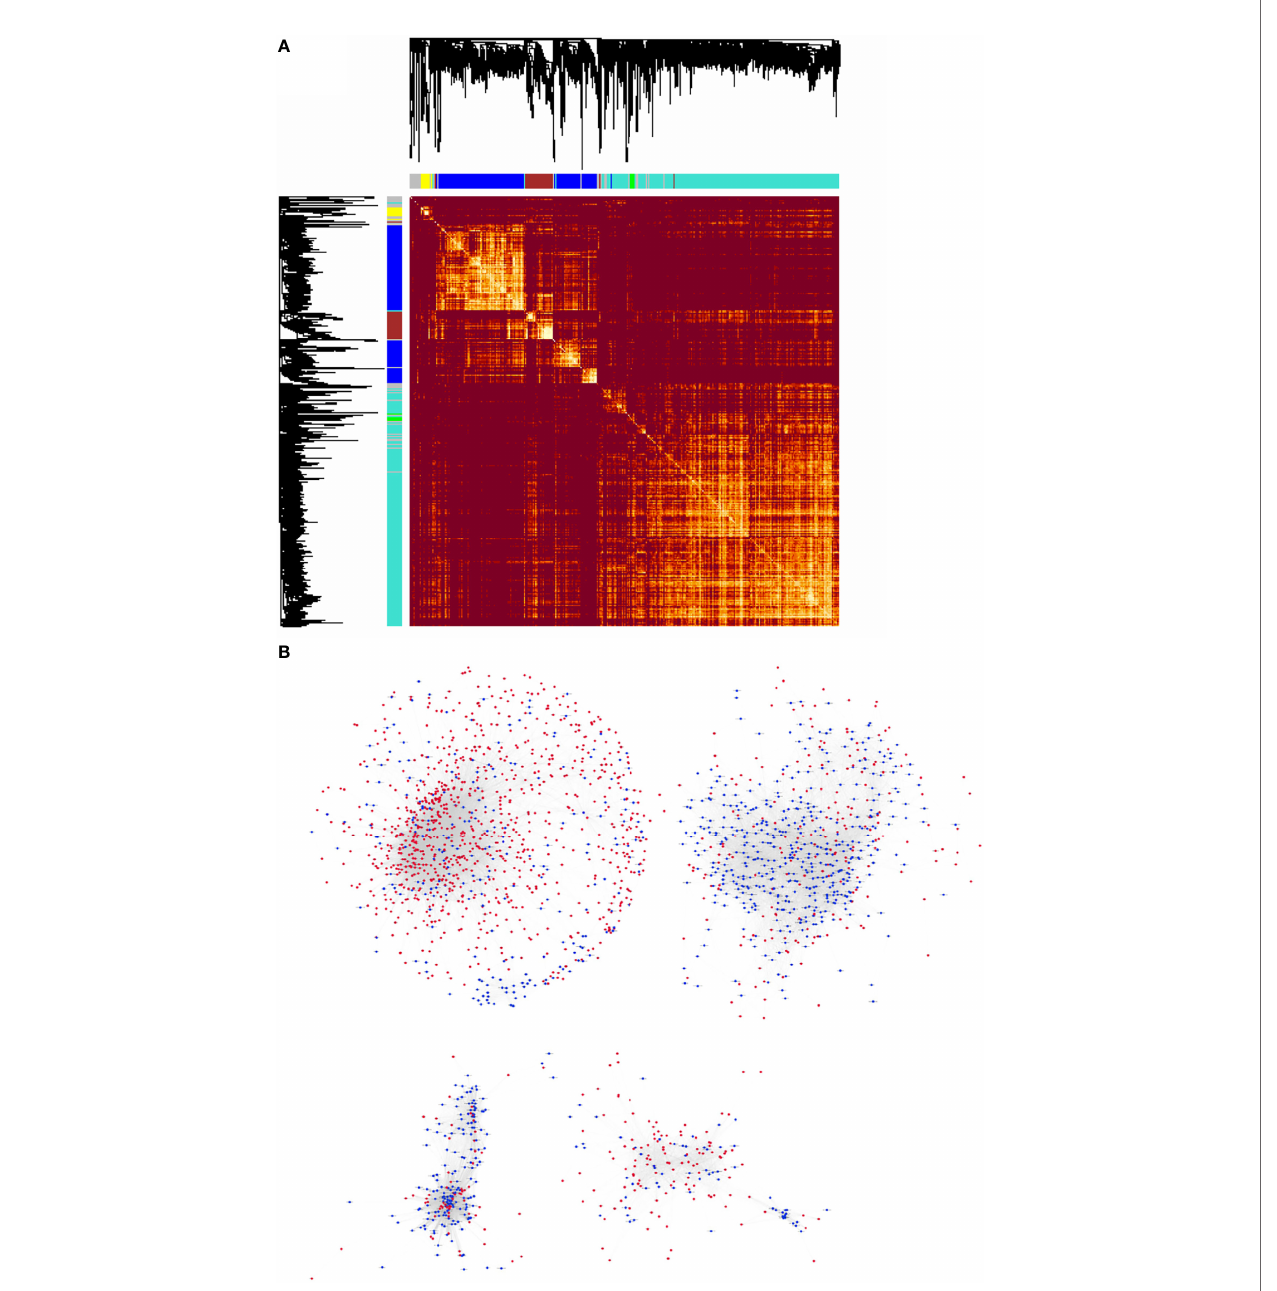
FIGURE 5 | The lncRNA – mRNA co-expression network for NPC was constructed using WGCNA. (A) Heatmap of the topological overlap matrix of all the differentially expressed lncRNAs and mRNAs in NPC. The elements above and the left of the heatmap are hierarchical clustering trees. The different branches of the clustering tree represent different gene modules and have been displayed as different colored boxes. (B) Highly correlated, co-expressed lncRNAs and mRNAs with topological overlap greater than 0.09 were selected. They formed the basis of the lncRNA – mRNA co-expression network of NPC, which was illustrated using the Cytoscape software. There were 2,196 nodes (915 lncRNAs and 1,281 mRNAs) and 35,290 connections (or relationships) in the co-expression